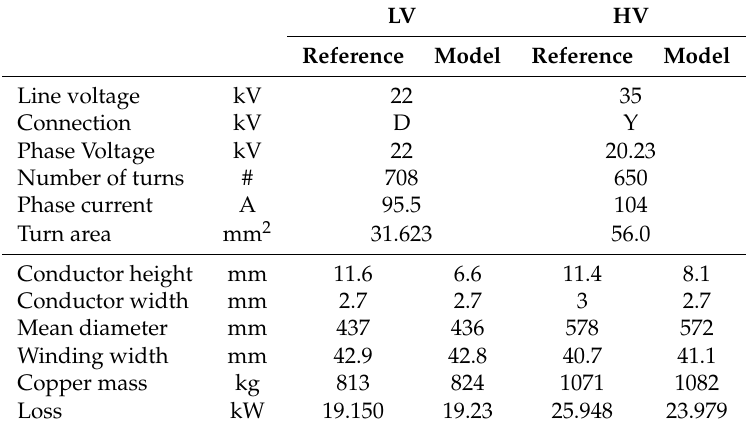
Table 2. Parameters of the low and high voltage windings of the validated